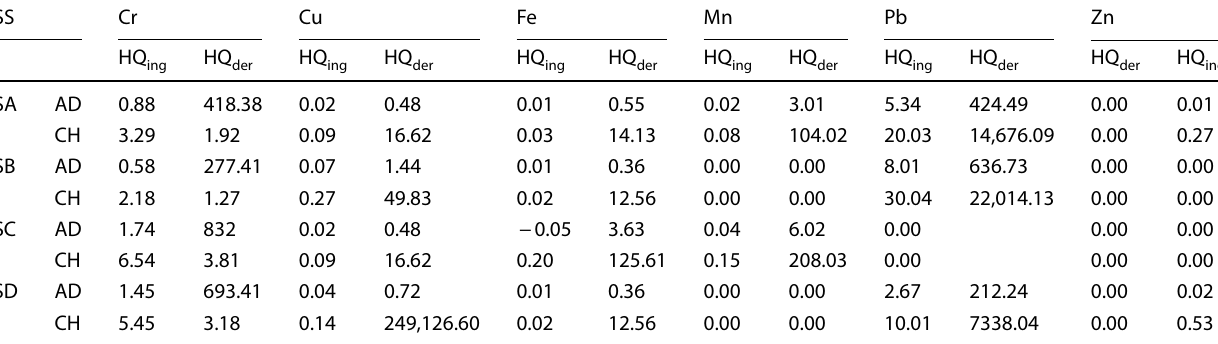
Table 7 Hazard quotient calculations for the PTE in the water bodies for adults and children